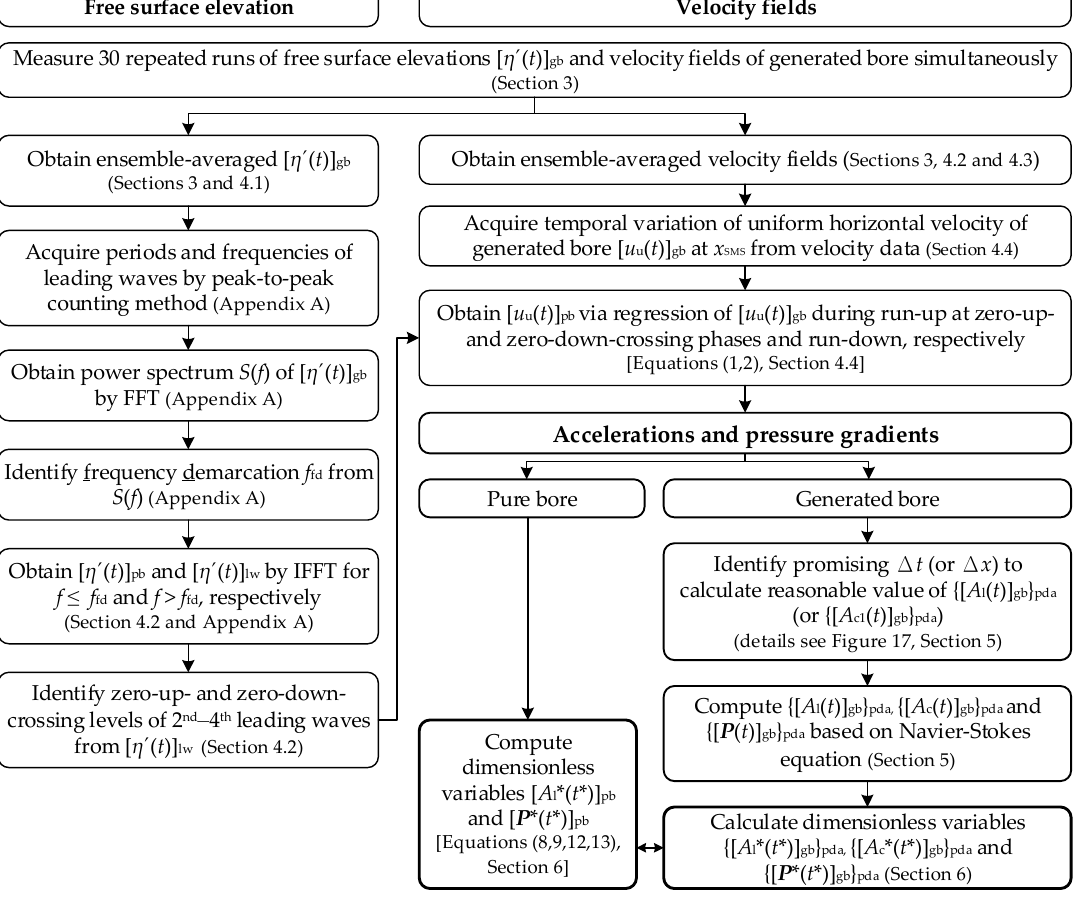
Figure 22. Flow chart systematically illustrating relationships among free surface elevations, velocities, accelerations, and pressure gradients of pure and generated bores.